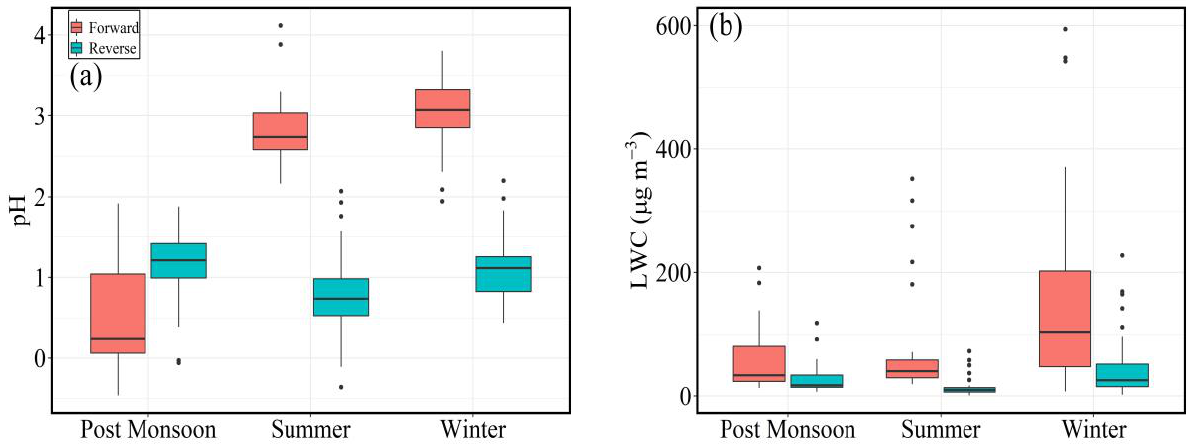
Figure 2. Box plots showing seasonal variability of ( a ) aerosol pH and ( b ) liquid water content of PM 2.5 estimated using forward and reverse during the study period at Goa. The scatter plot between estimated pH for different seasons in forward and reverse mode is displayed in Figure 3a,b. Aerosol pH is overestimated in forward mode with a correlation (r 2 = 0.26; p < 0.005) observed for the summer and winter months samples. However, a relatively large scatter with under-estimated aerosol pH is found for the reverse mode for the post-monsoon samples.